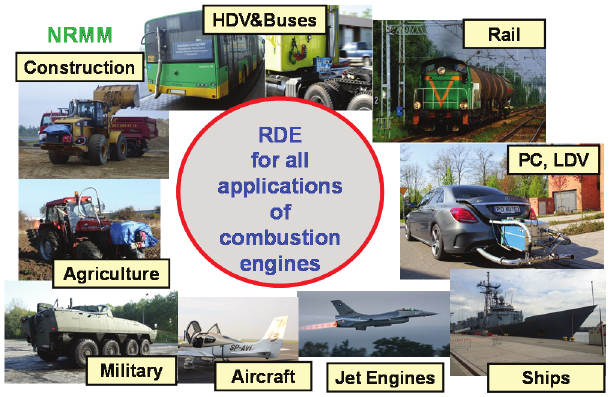
Fig. 2. Poznan University of Technology – large experience in RDE measurements [24]